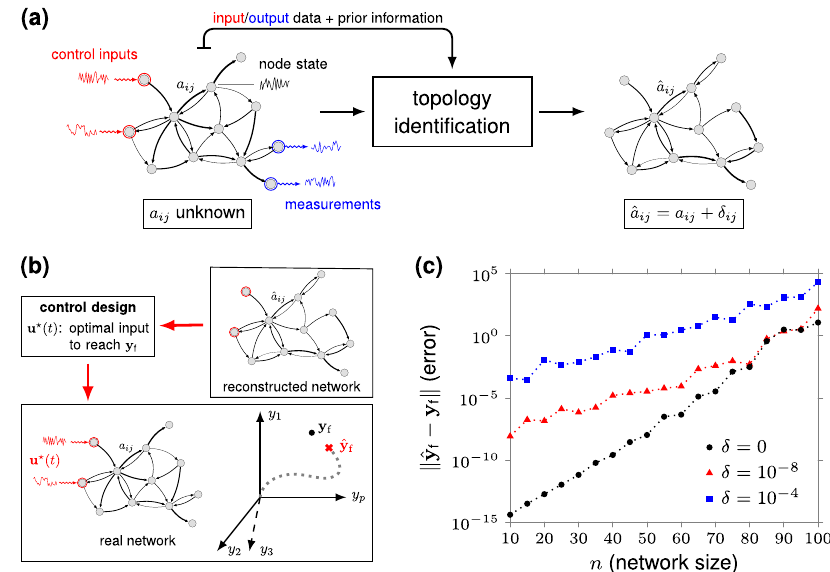
Fig. 1 The effect of model uncertainty in the computation of optimal network controls. Panel ( a ) shows a schematic of a classic network identi fi cation procedure. The reconstructed network is affected by estimation errors δ ij . The symbol { a ij } denote the correct network weights, whereas f ^ a ij g